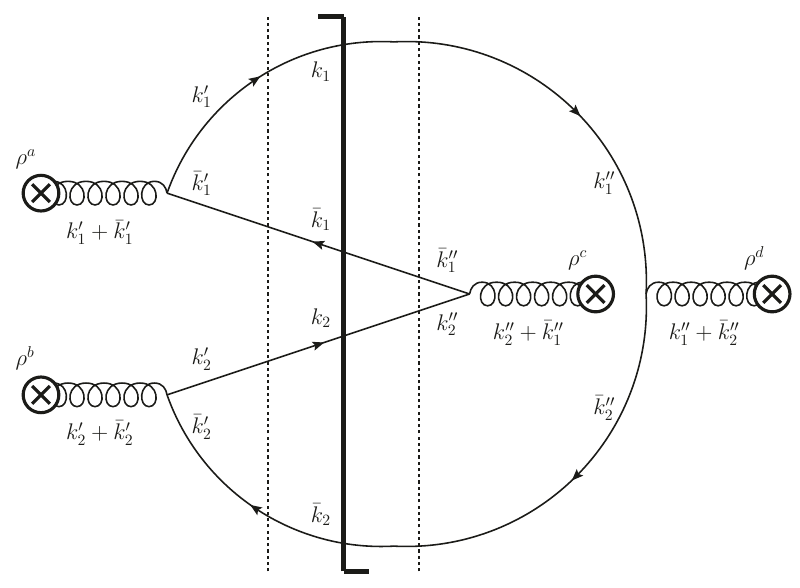
Figure 6 . Double-pair production \Pac Man" topologies with fermion entanglement, as calculated in eq.